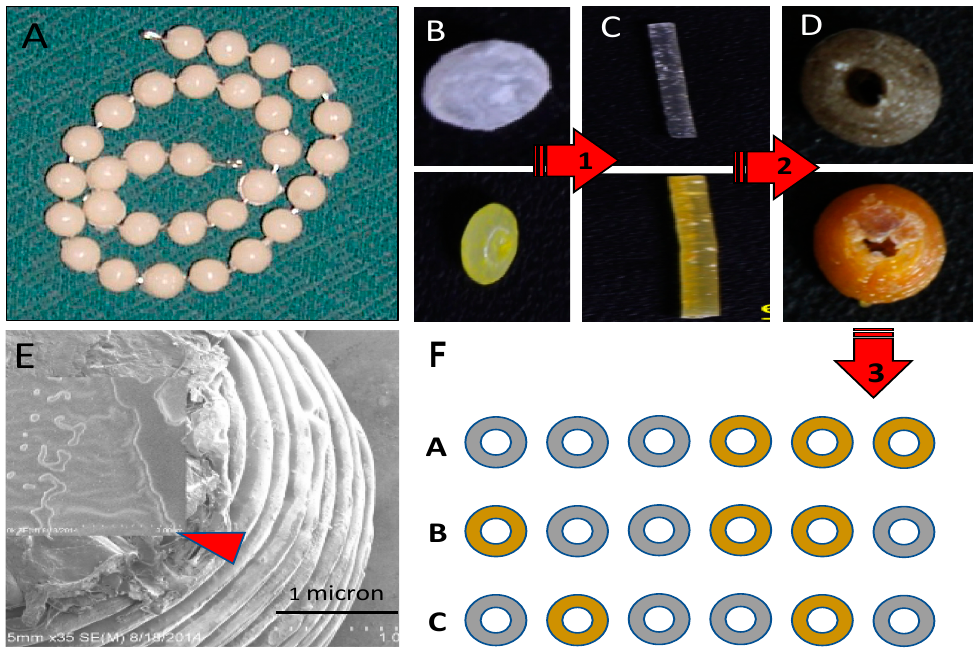
Figure 10. ( A ) Commercially available antibiotic-laden PMMA bead string. ( B ) Drug doped PLA pellets, gentamicin pellet (upper figure) and methotrexate pellet (lower figure); ( C ) Extruded drug-doped-filaments. Gentamicin-doped filament (upper figure) and methotrexate-doped filament (lower figure). ( D ) 3D printed drug doped beads. These can then be assembled into implantable bead strings. Gentamicin bead (upper figure) and methotrexate bead (lower figure). ( E ) SEM of a 3D printed bead showing later-by-layer assembly with gentamicin crystals embedded within the assembled layers. (red arrow, insert). ( F ) Potential antibiotic designs demonstrating the potential for 3D printing diverse sets of bioresorbable bead strings. Arrows (1–3) indicates the direction of the fabrication process (pellet>>>extruded filament>>>3D printed bead).